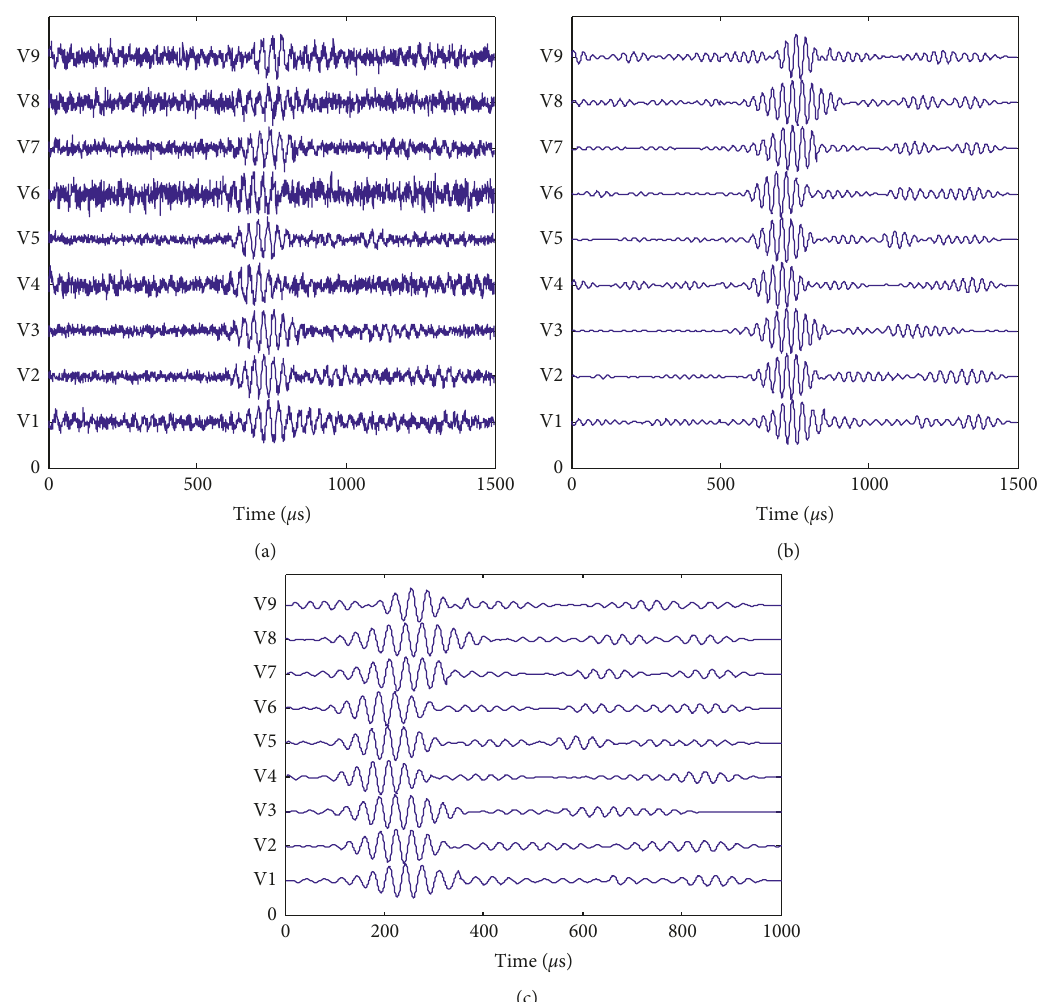
Figure 11: Original and preprocessed scattering signals obtained at S5 position of the excitation source: (a) original scattering signal; (b) filtered scattering signal; (c) scattering signal after